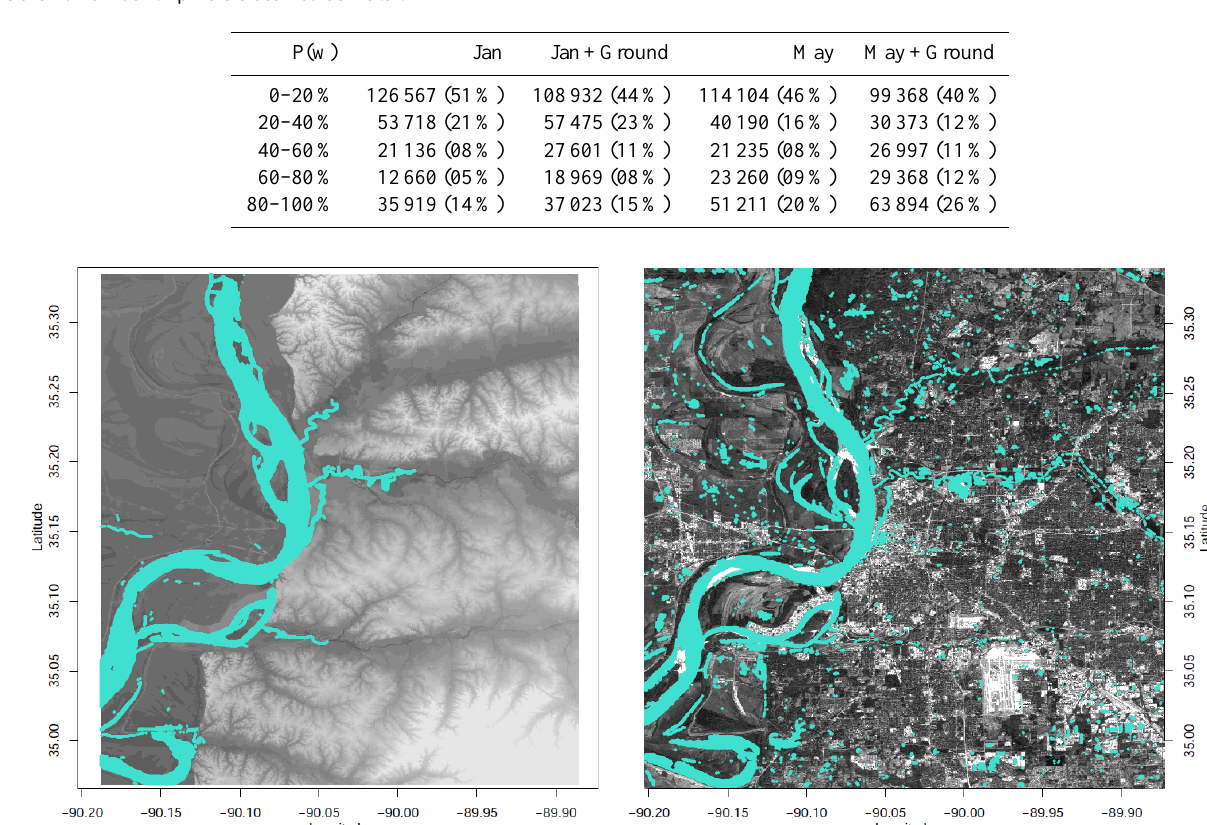
Table 1. Number of pixels classified as water.